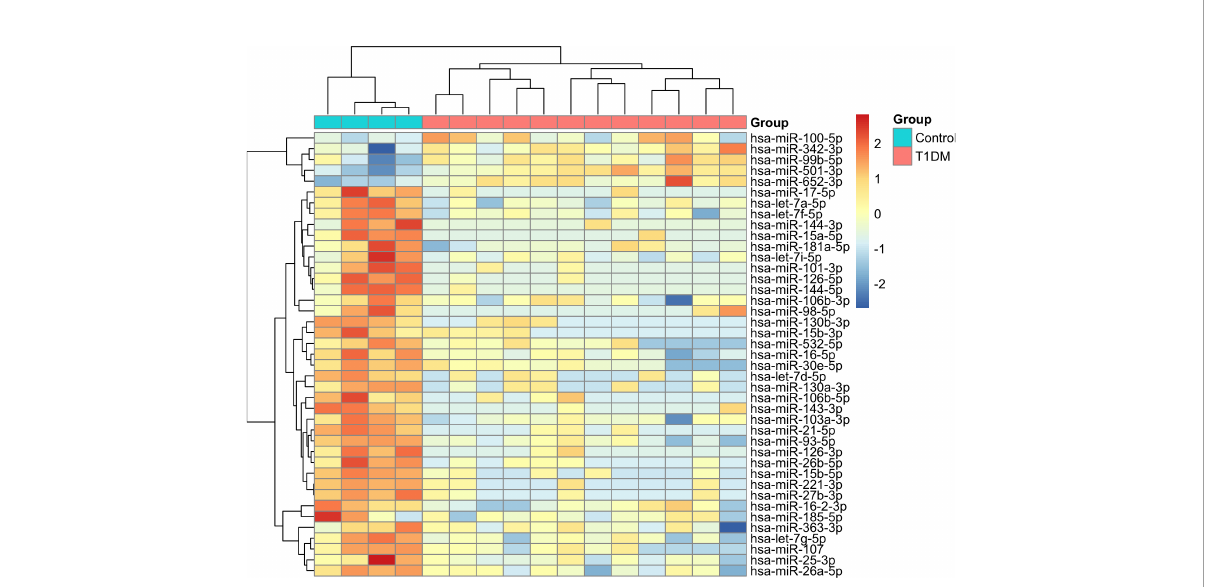
FIGURE 3 Heatmap with hierarchical clustering analysis of DE miRNAs in T1DM. Blue color in top bar represents control individuals and red colors represents T1DM patients. In the heatmap, dark-red color corresponds to high miRNA expression, and dark blue corresponds to low